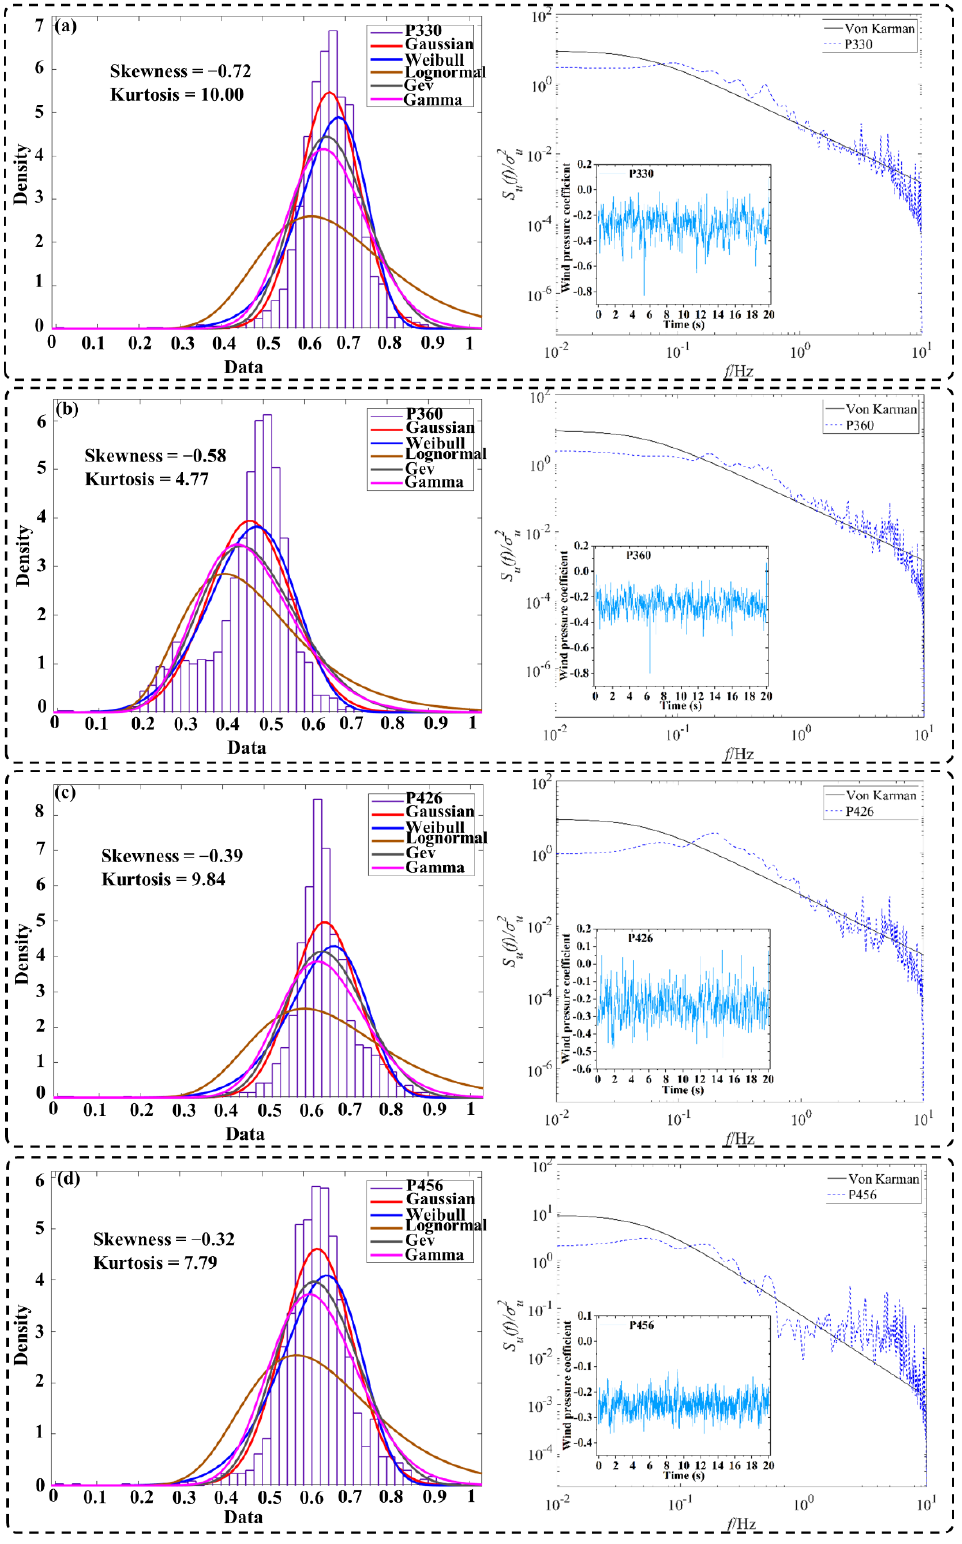
Figure 9. Probability distribution, wind pressure time series and normalized wind pressure coefficient power spectrum of representative measurement points at 0° wind angle: ( a ) P330; ( b ) P360; ( c ) P426; ( d ) P456. P330; and P360 refer to the upper surface measurement points of the roof, while P426 and P456 are the bottoms.